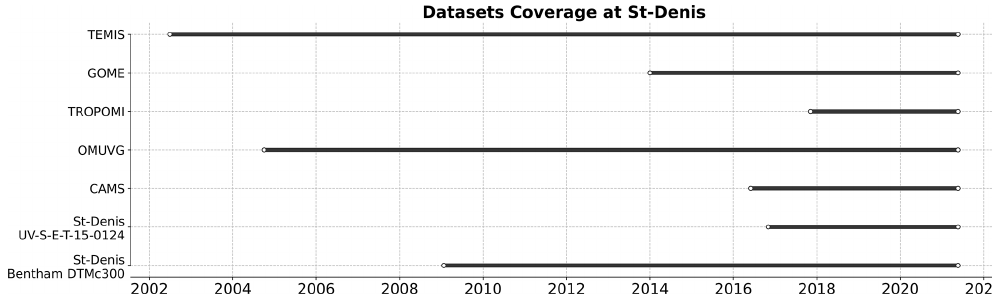
Figure A9. Timeline of the instruments of the UVI dataset used in the comparison at Saint-Denis.